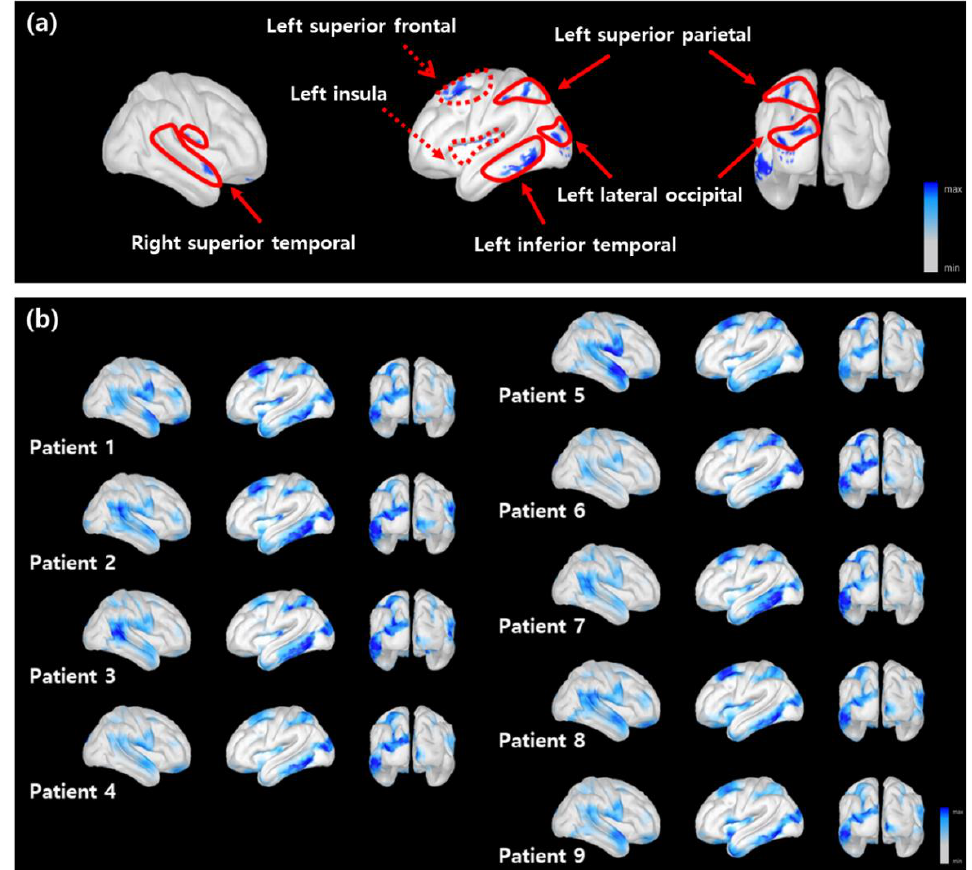
Figure 3. The distribution of the relevance scores on the cortical surface. ( a ) The LRP heatmap averaged over multiple subjects. The critical regions with the top 3% relevance scores (denoted by a blue shading). The solid and dotted lines indicate the cortical areas related to visual processing and executive control, respectively. ( b ) The LRP heatmaps for all subjects obtained from correctly classified results.